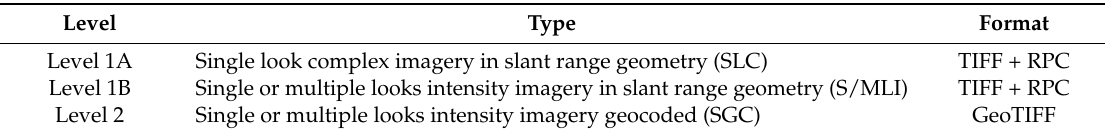
Table 1. Product Formats of